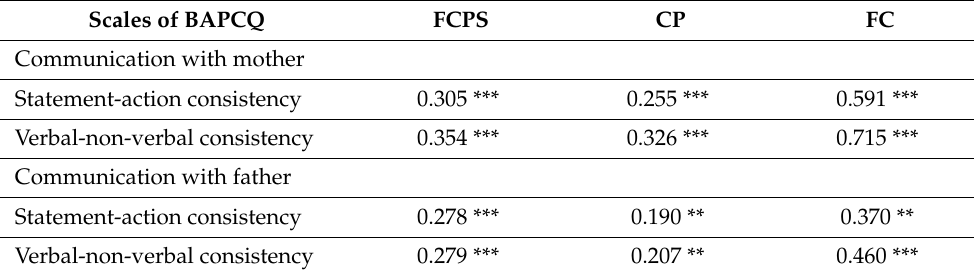
Table 6. Correlations between the BAPCQ and scale of validation